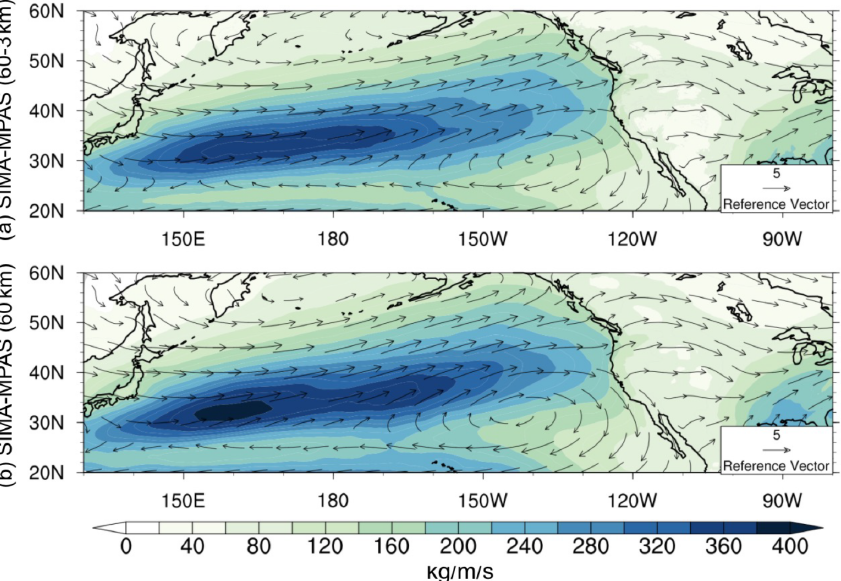
Figure 10. Mean instantaneous vertically integrated water vapor flux transport over the western USA (2000–2002, November–March): (a) SIMA-MPAS 60–3km and (b) SIMA-MPAS 60km. Wind is overlaid for the averaged lower levels (height from ∼ 500 to ∼